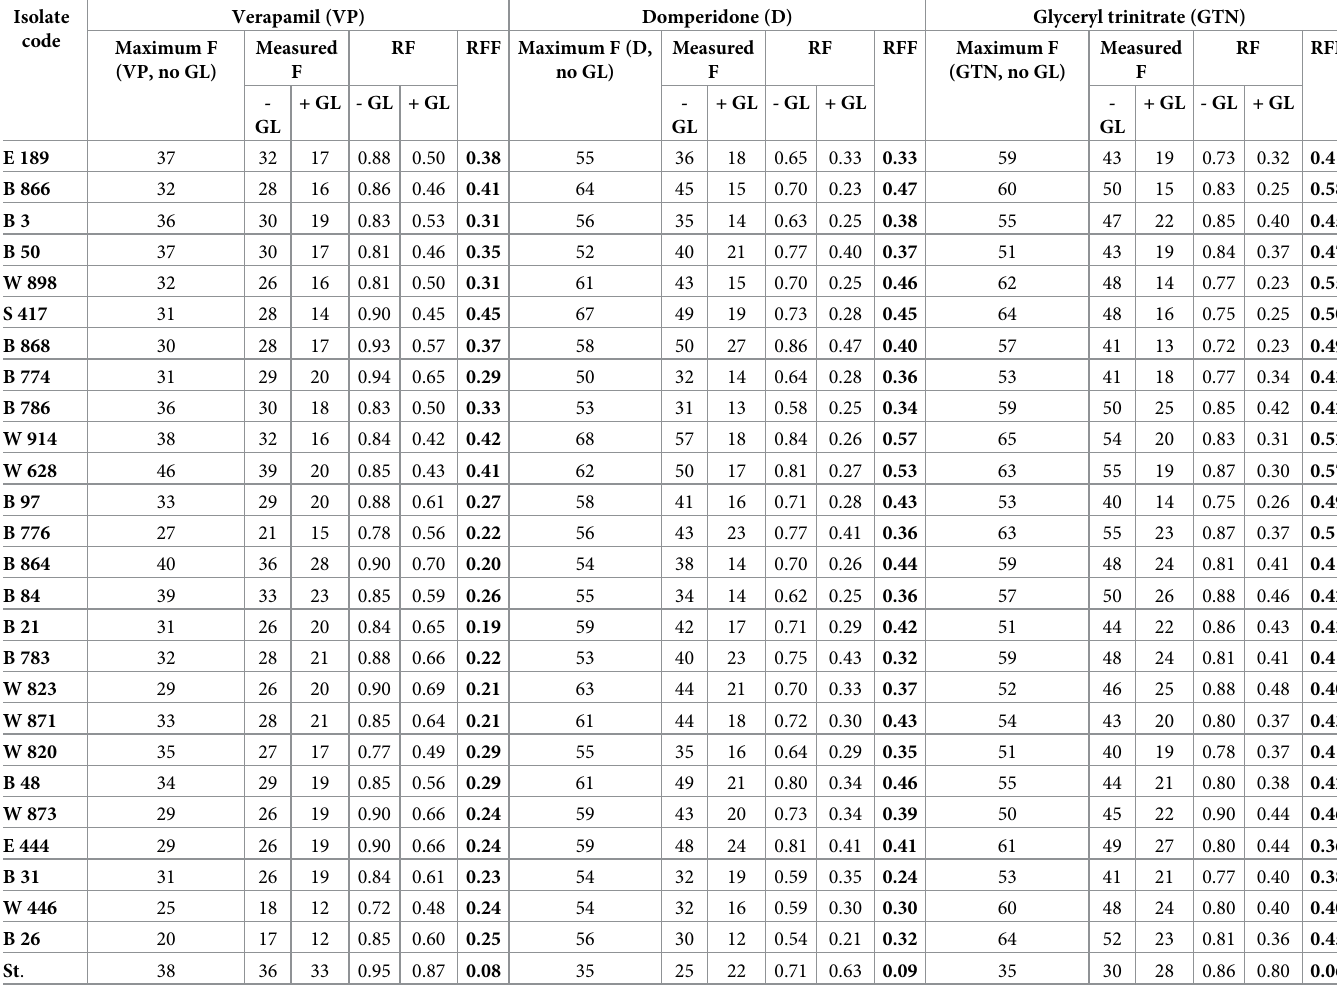
Table 3. Fluorometric efflux assay of isolates in the presence of verapamil, domperidone and glyceryl trinitrate. Isolate